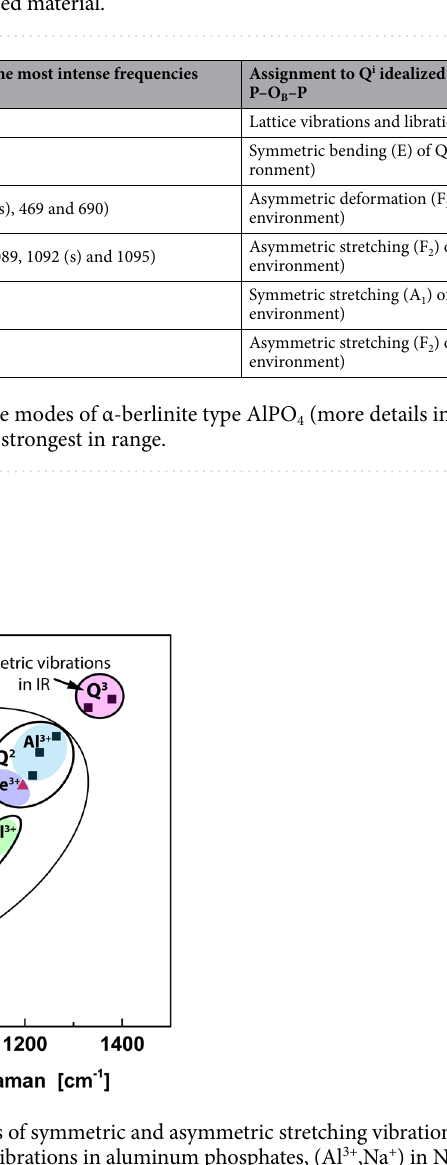
Figure 17. Calculated Raman and IR spectra of α-berlinite type AlPO 4 shifted by + 20 cm −1 and experimental IR and Raman spectra (Exp.) of the synthesized material.